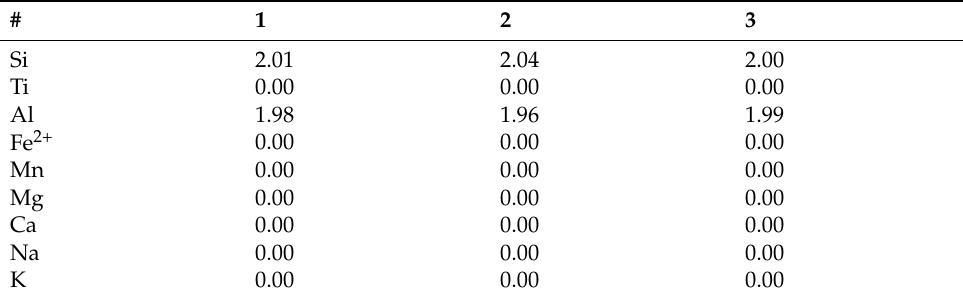
Table 2. TEM-EDX analyses of kaolinite. Apfu; 7 oxygen